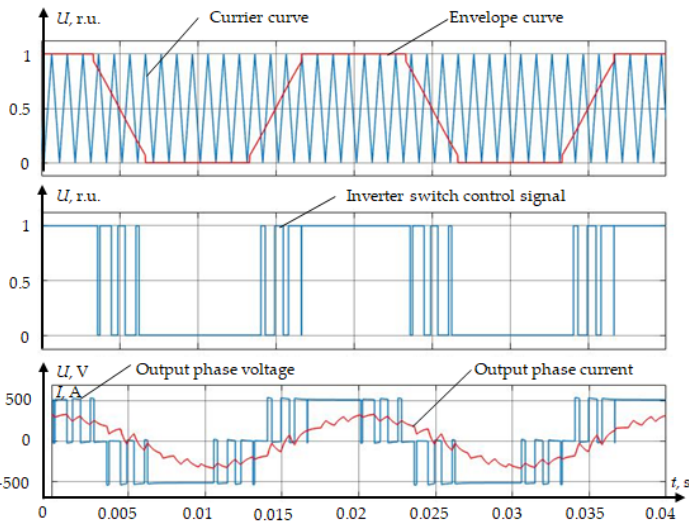
Figure 8. Simulation results at 60 electrical degrees angle of connection (T = 80 °C).